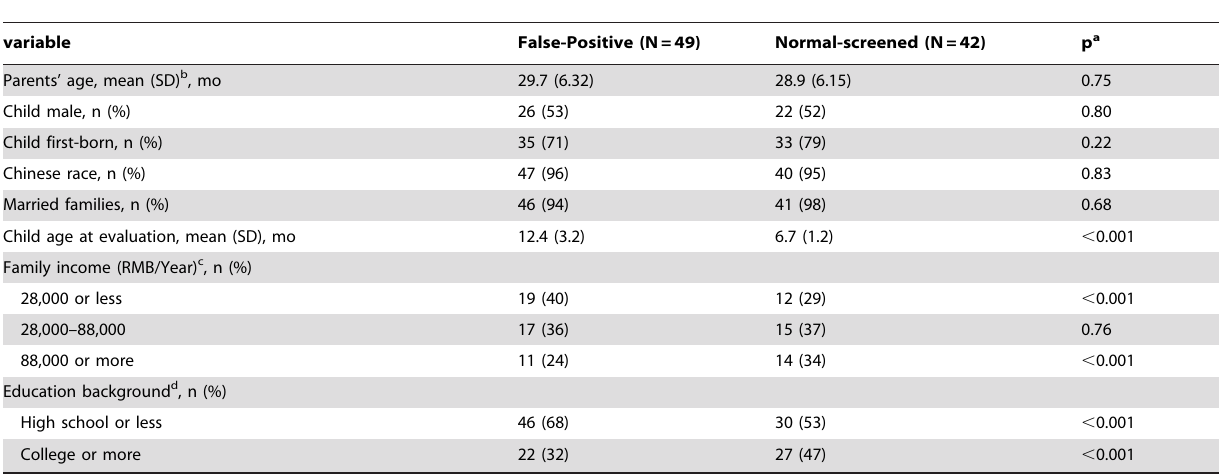
Table 1. Comparison of demographic profiles of the